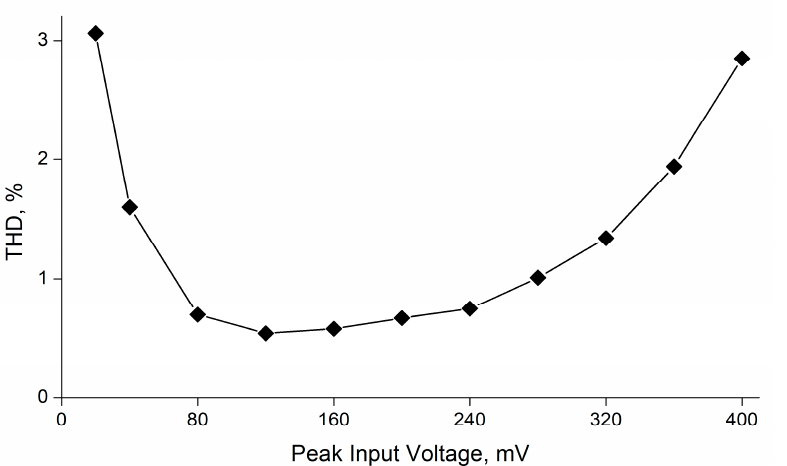
Figure 12. THD variations of the HP ladder filter for various amplitudes of the peak-input voltages at 2.5 MHz.